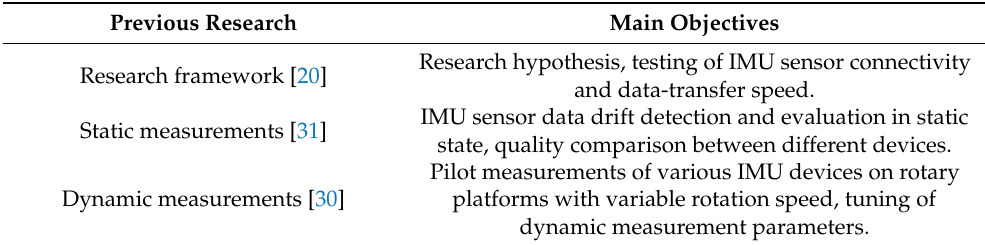
Table 1. Overview of previous measurements on IMU sensors as pilot studies for the research presented in this paper.